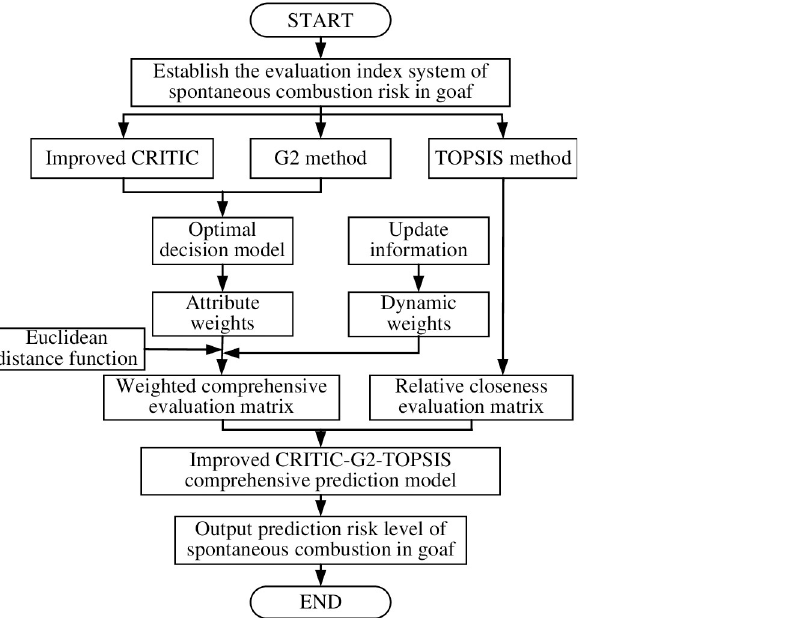
Fig 1. Flowchart of the G2-TOPSIS dynamic evaluation